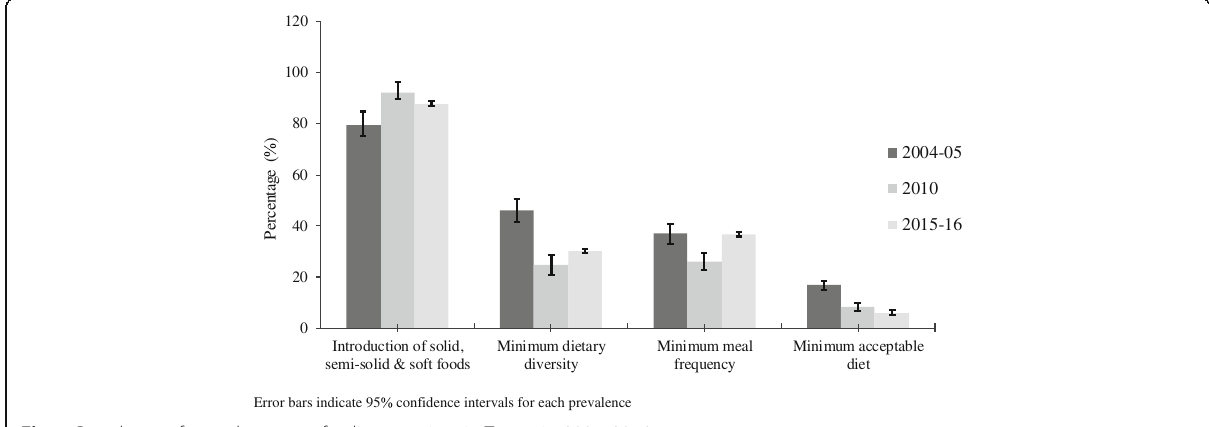
Fig. 1 Prevalence of complementary feeding practices in Tanzania, 2004 –